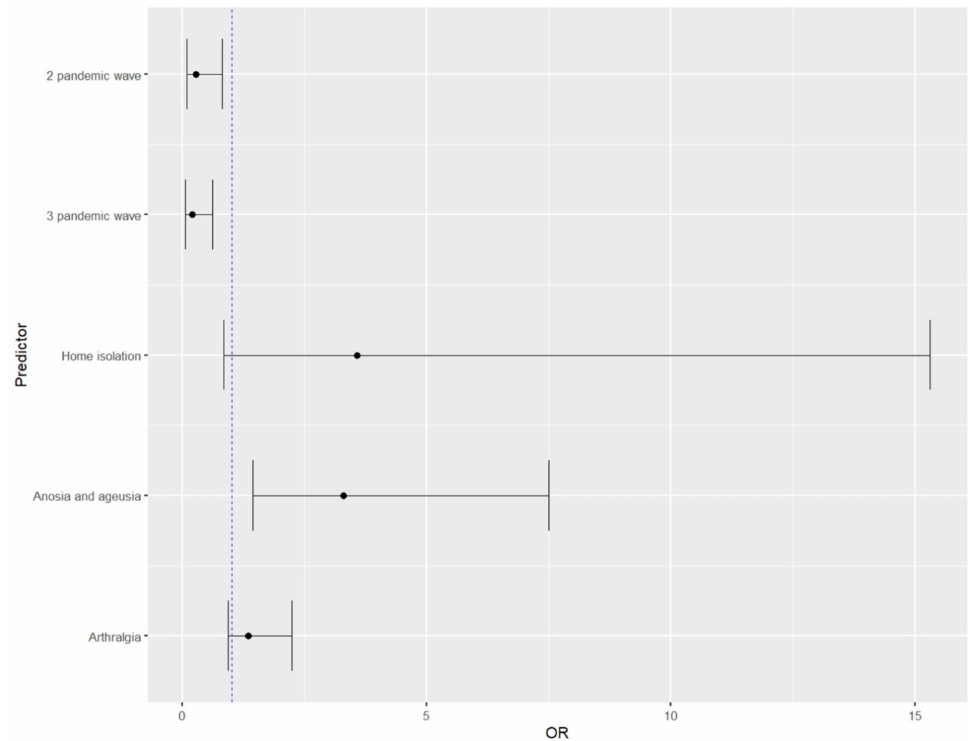
Figure 2. Graphical representation of multivariate analysis based on a model incorporating statisti- cally significant predictors from univariate analysis determining the risk of developing persistent smell and taste